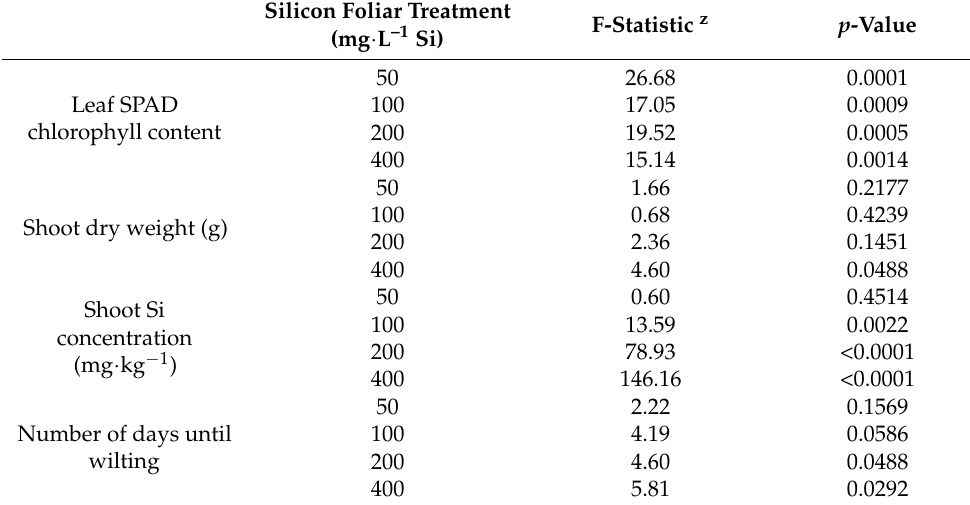
Table 1. Statistical parameters for silicon (Si) foliar sprays (50, 100, 200, 400 mg · L –1 Si) compared to